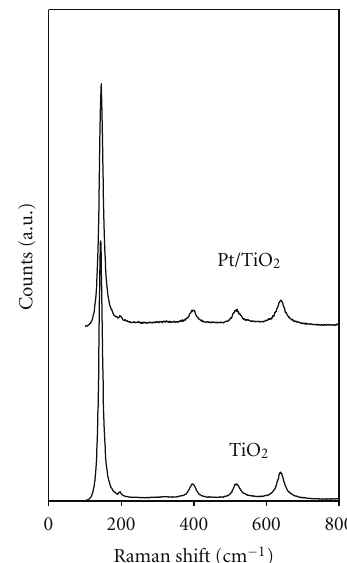
using an ultrasonicator and dropped on a carbon grid. The platinum particle sizes were evaluated by TEM, in a micro- scope Philips CM 200.